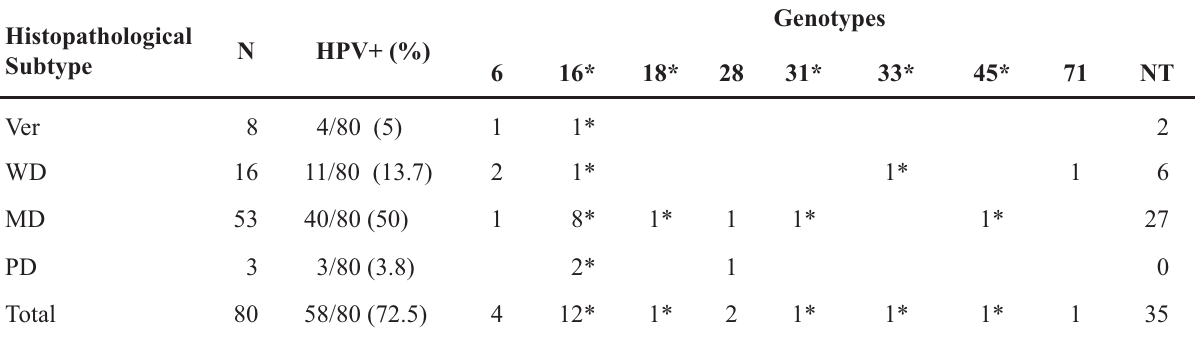
Table 1 – HPV genotyping of penile tumors according to the pathological subtype. Histopathological